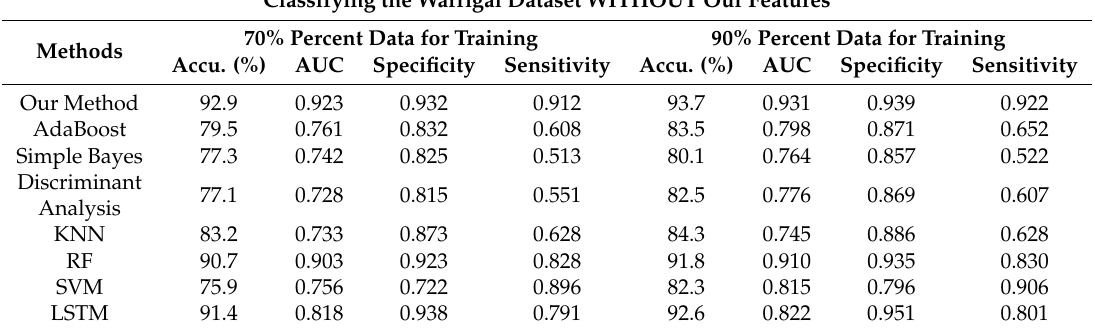
Table 5. The comparison among eight methods on the Warrigal dataset without our time-series features. The proposed method gets the highest values of accuracy and AUC.